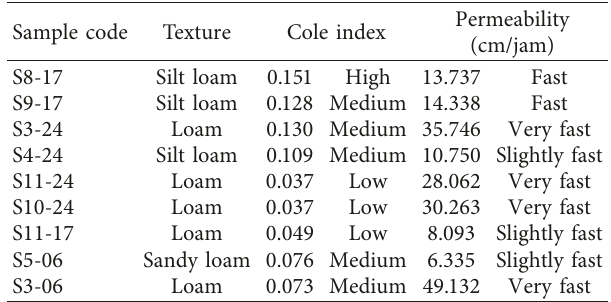
Table 5: Selective samples of soil properties at erosional and depositional